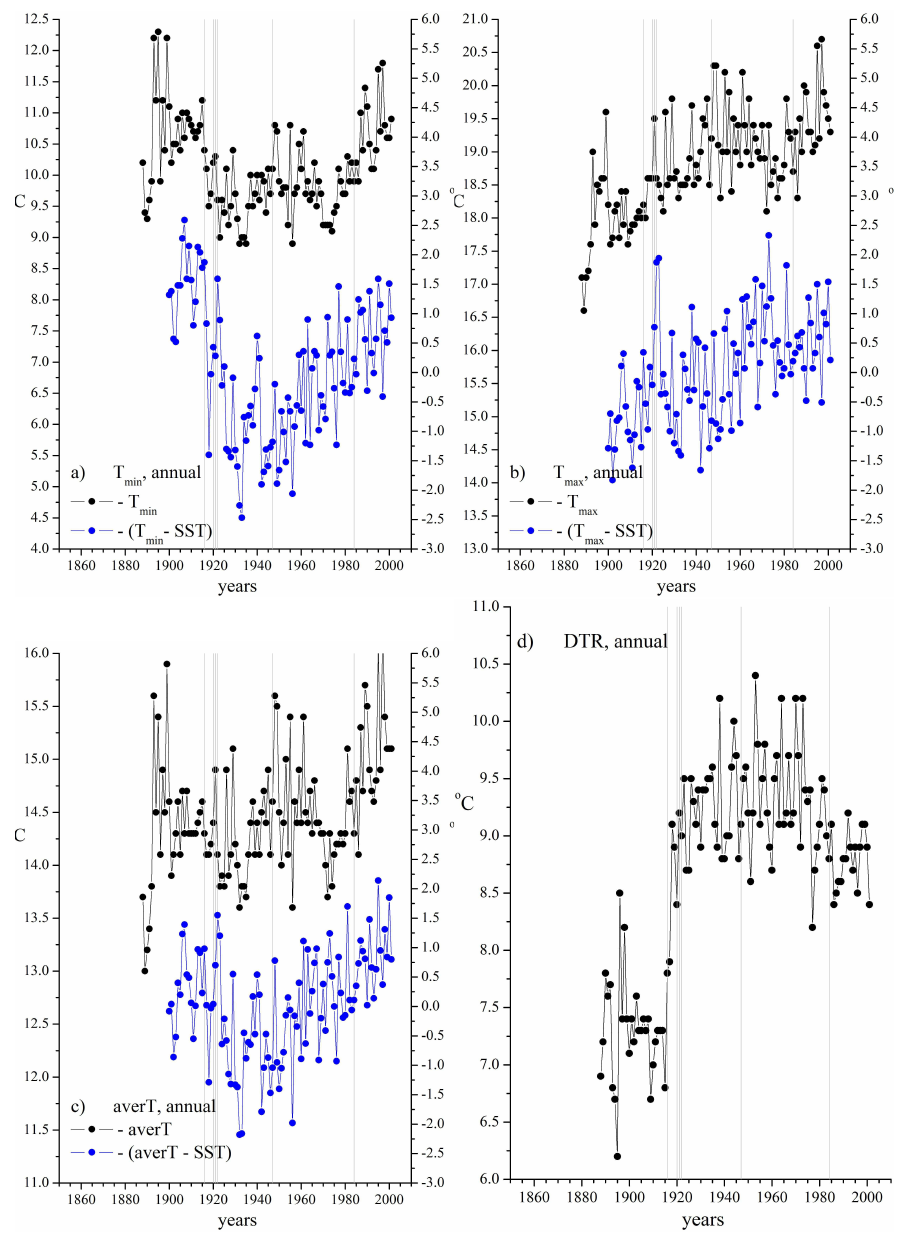
Figure 3. Porto: annual variations of T min (a) , T max (b) , T aver (c) and DTR (d) ; temperature series are shown in black, di ff erences between temperature and SST Porto series are shown in blue. Grey vertical bands show dates of known instruments relocation (see Table